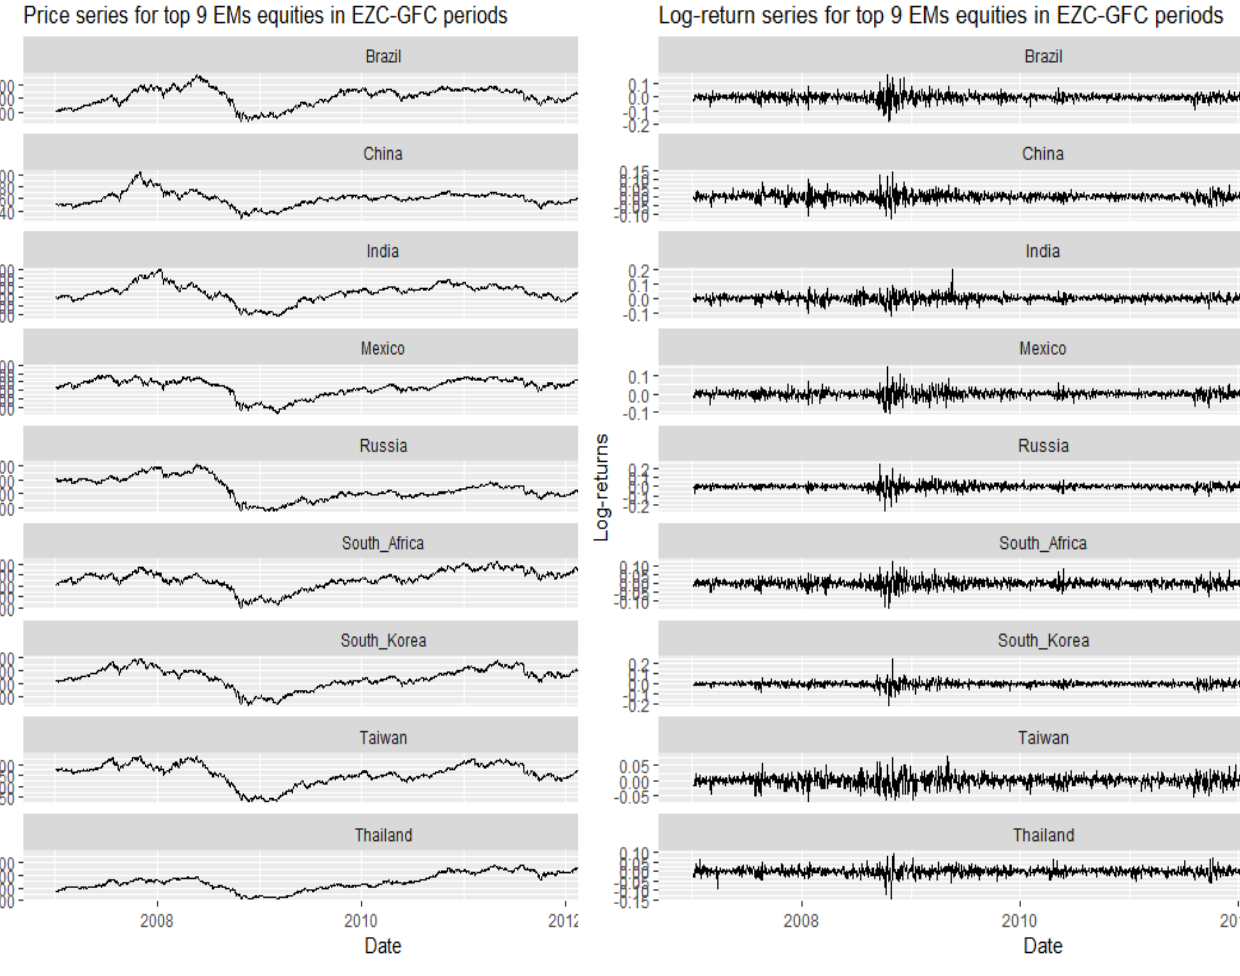
Figure 1. Price and log-return plots of the top 9 EMs equities in EC-GFC